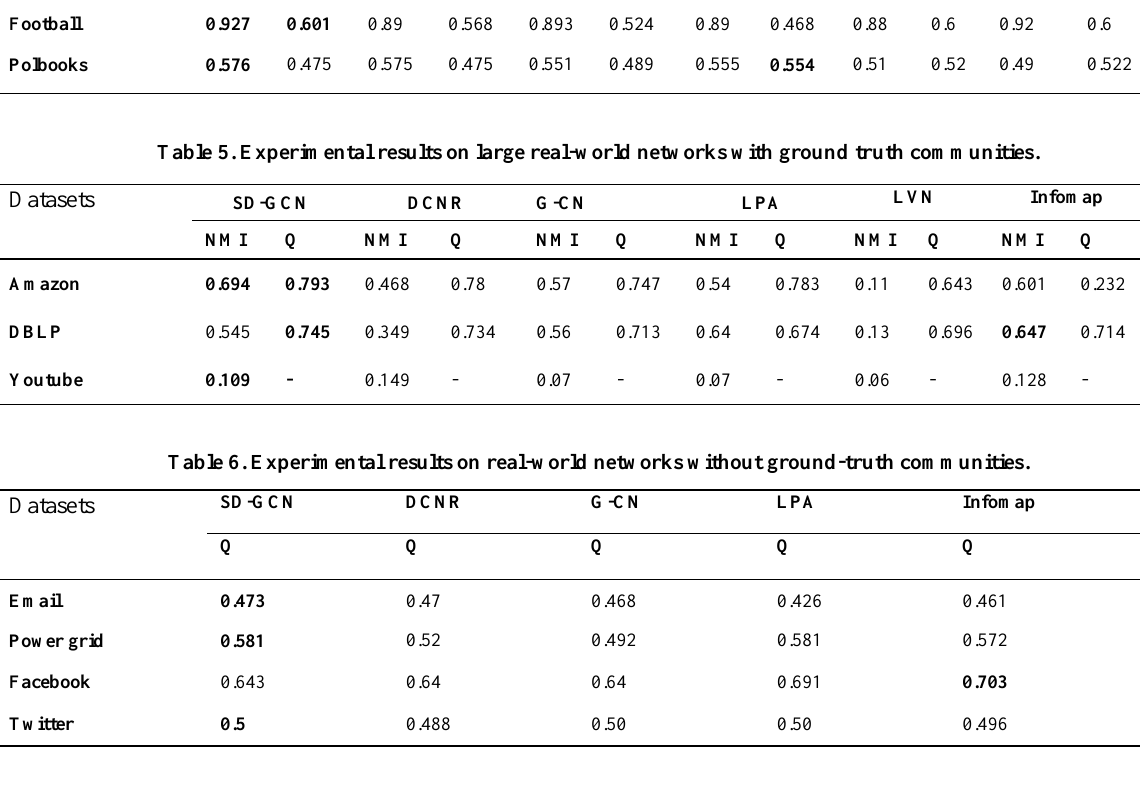
Table 7. Execution time (ms).